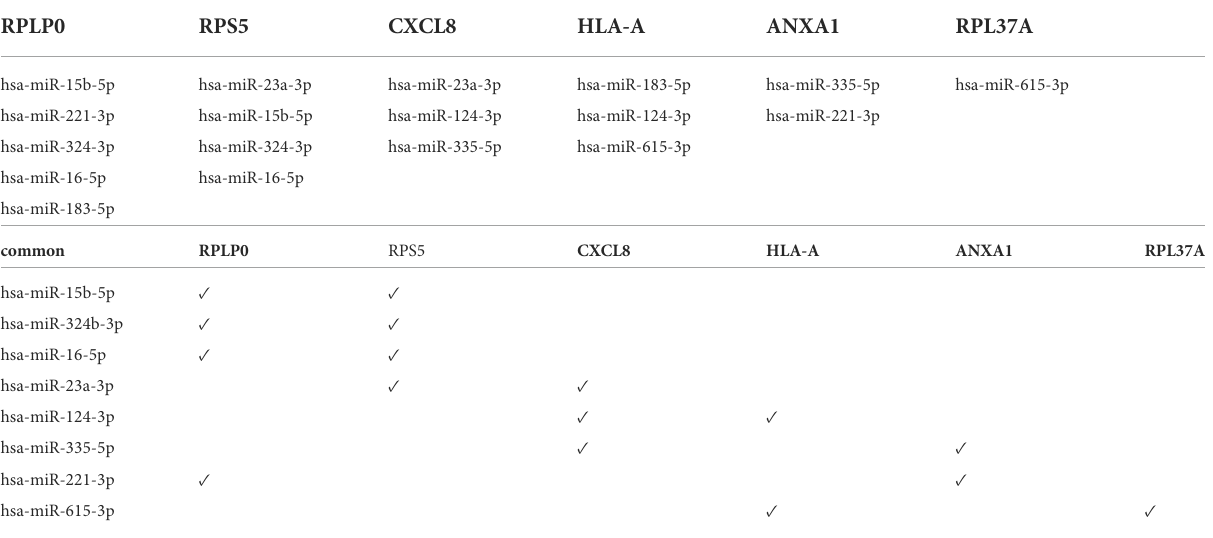
TABLE 5 The table shows the list of miRNAs associated with six selected hub